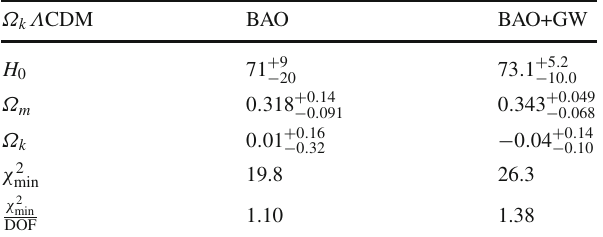
Table 2 The 68% CL constraints on the independent parameters of the